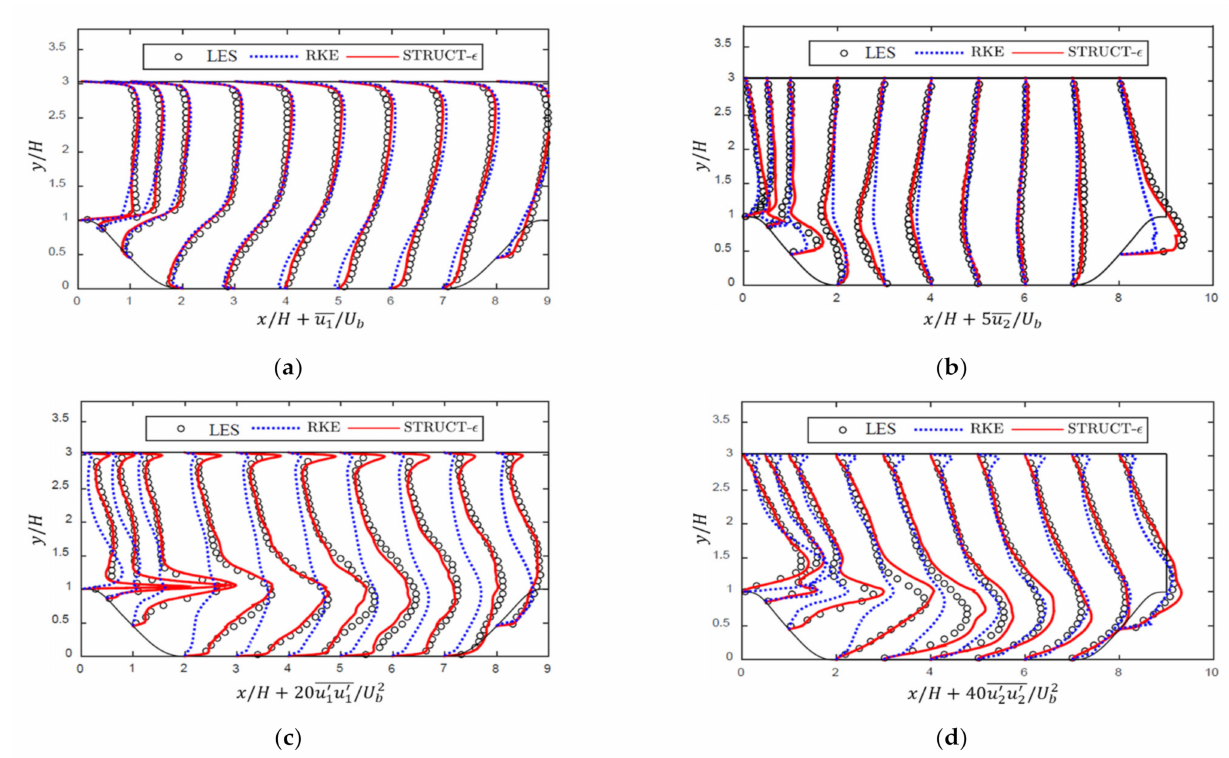
Figure 3. Comparison of ( a ) streamwise mean velocity profiles ( u 1 ), ( b ) transverse-normal mean velocity profiles ( u 2 ), ( c ) u 1 (cid:48) ), ( d ) turbulent transverse-normal stress profiles ( u (cid:48) turbulent streamwise stress profiles ( u (cid:48) 1 STRUCT- ε models and the LES solution in the XY symmetry plane of the periodic hill